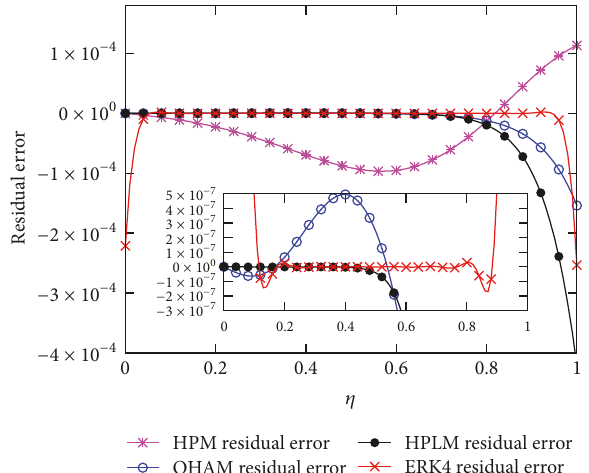
Figure 2: Residual error of HPM, OHAM, HPLM, and ERK4 for Reynolds number 𝑅 = 0.5 . In the inset, a more finer resolution of the residual error of OHAM, HPLM, and ERK4 is shown.